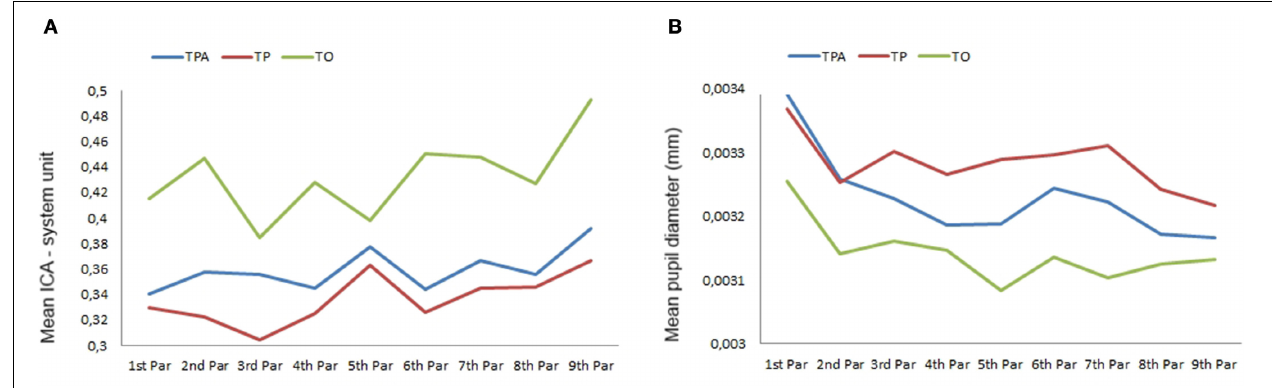
FIGURE 2 | Phase 2—Mean ICA (A) and mean pupil diameter (B) across each paragraphs read in the second article for text, pictures and animations (TPA); text and pictures (TP), and text-only (TO) version.